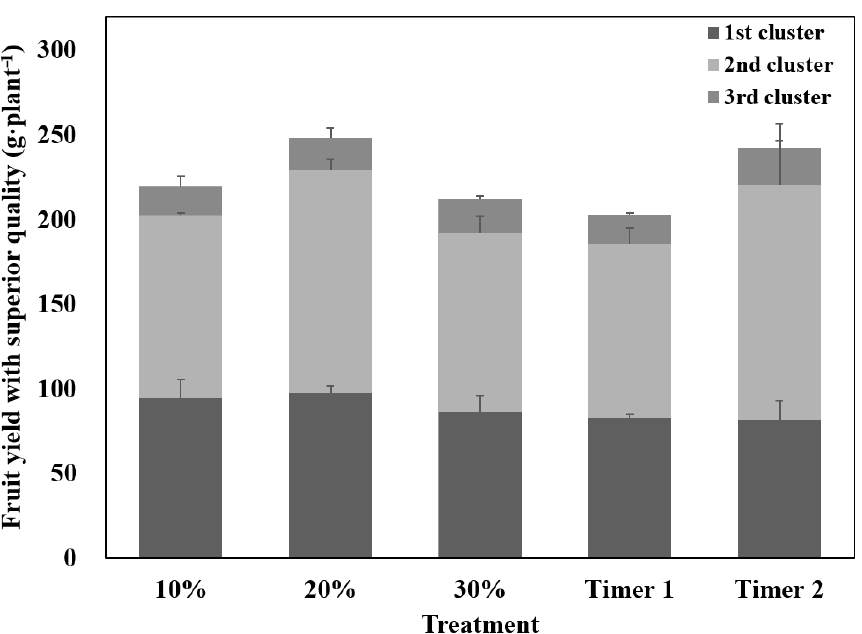
Figure 7. Fruit yield with superior quality (above 27 g) harvested from strawberry ‘Kuemsil’ affected